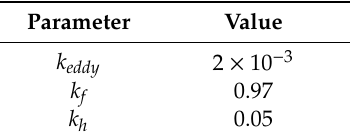
Table 2. The value of the coefficients.